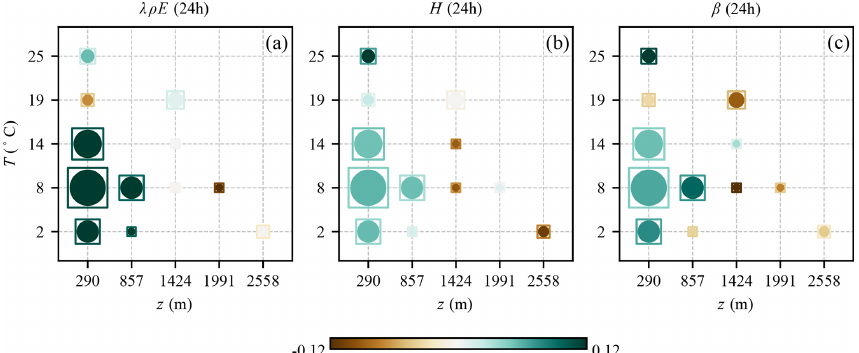
Figure 18. Standardized anomaly correlation difference (circles) and standardized mean absolute differences (squares) between ERA5-Land and GLEAM + ERA5-Land latent heat flux (a) , sensible heat flux (b) , and Bowen ratio (c) , grouped as a function of stations’ temperature and altitude. The size of circles and squares is proportional to the number of eddy-covariance towers. Green values denote better matching of ERA5-Land with in situ